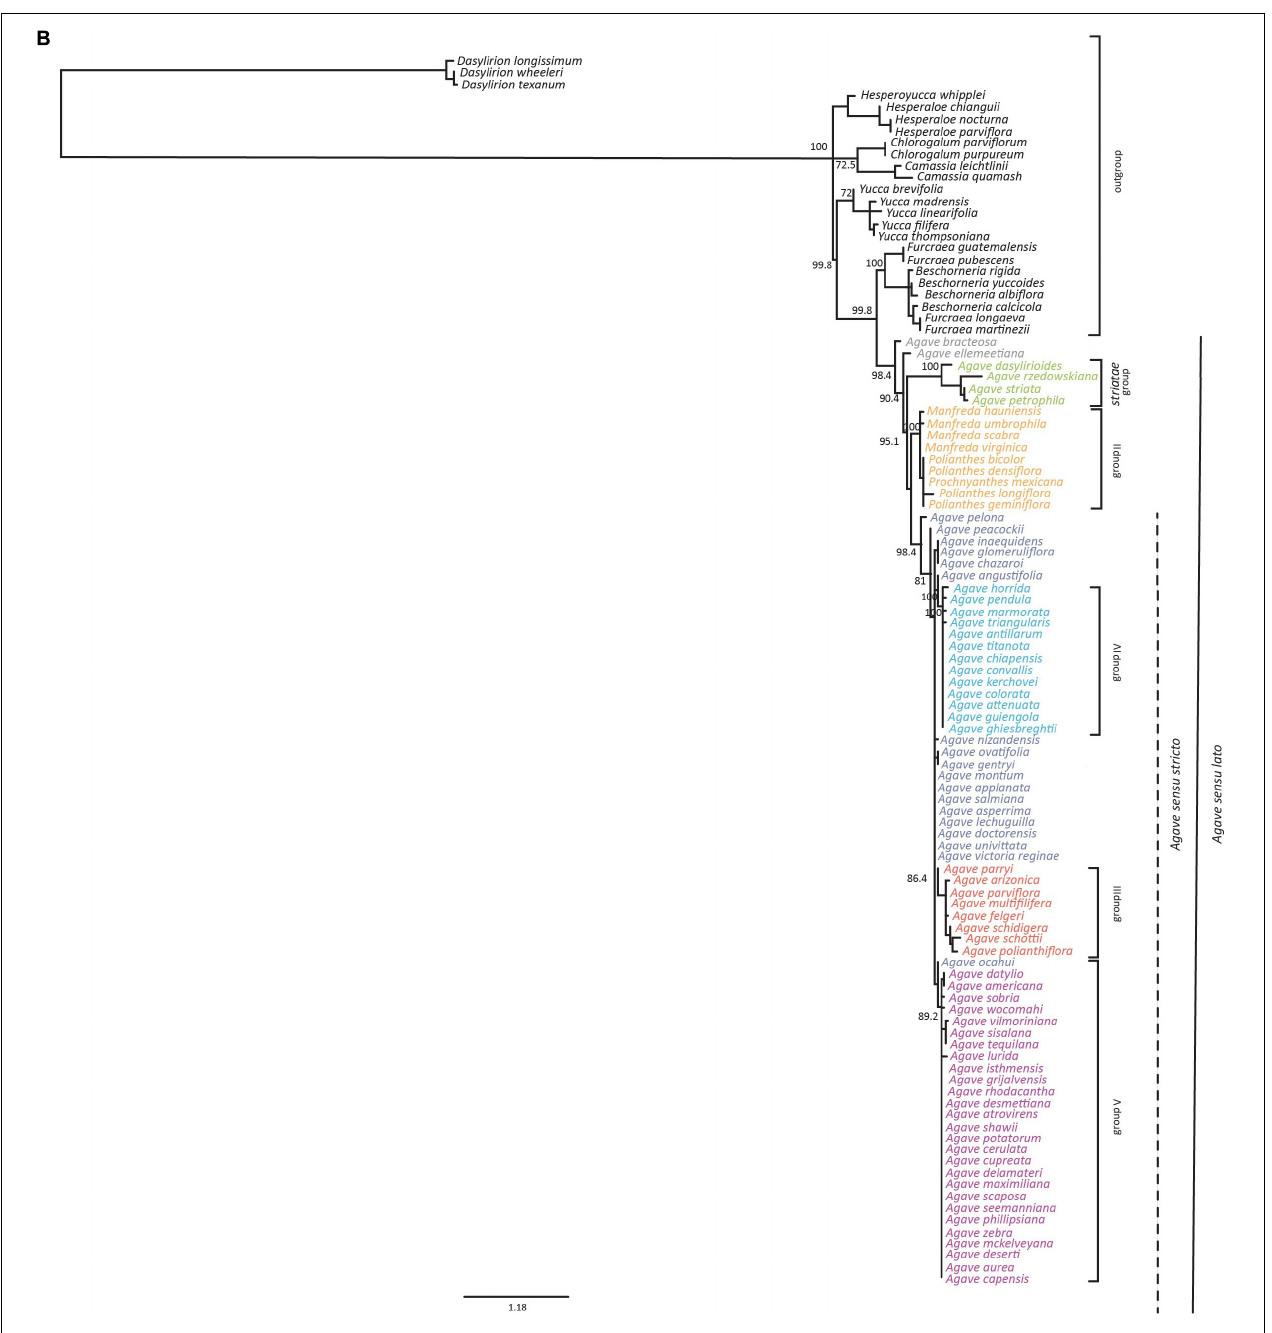
FIGURE 1 | (A) Molecular phylogeny of Agave sensu lato using Dasylirion as an outgroup reconstructed from the ITS sequences and using a Bayesian inference analysis. The numbers next to the nodes indicate the posterior probability values above 0.70. (B) Molecular phylogeny of Agave sensu lato using Dasylirion as an outgroup reconstructed from the ITS sequences and using a maximum likelihood analysis. Numbers next to the nodes are bootstrap values generated from running 1,000 replicates of the trees; only values above 70% are